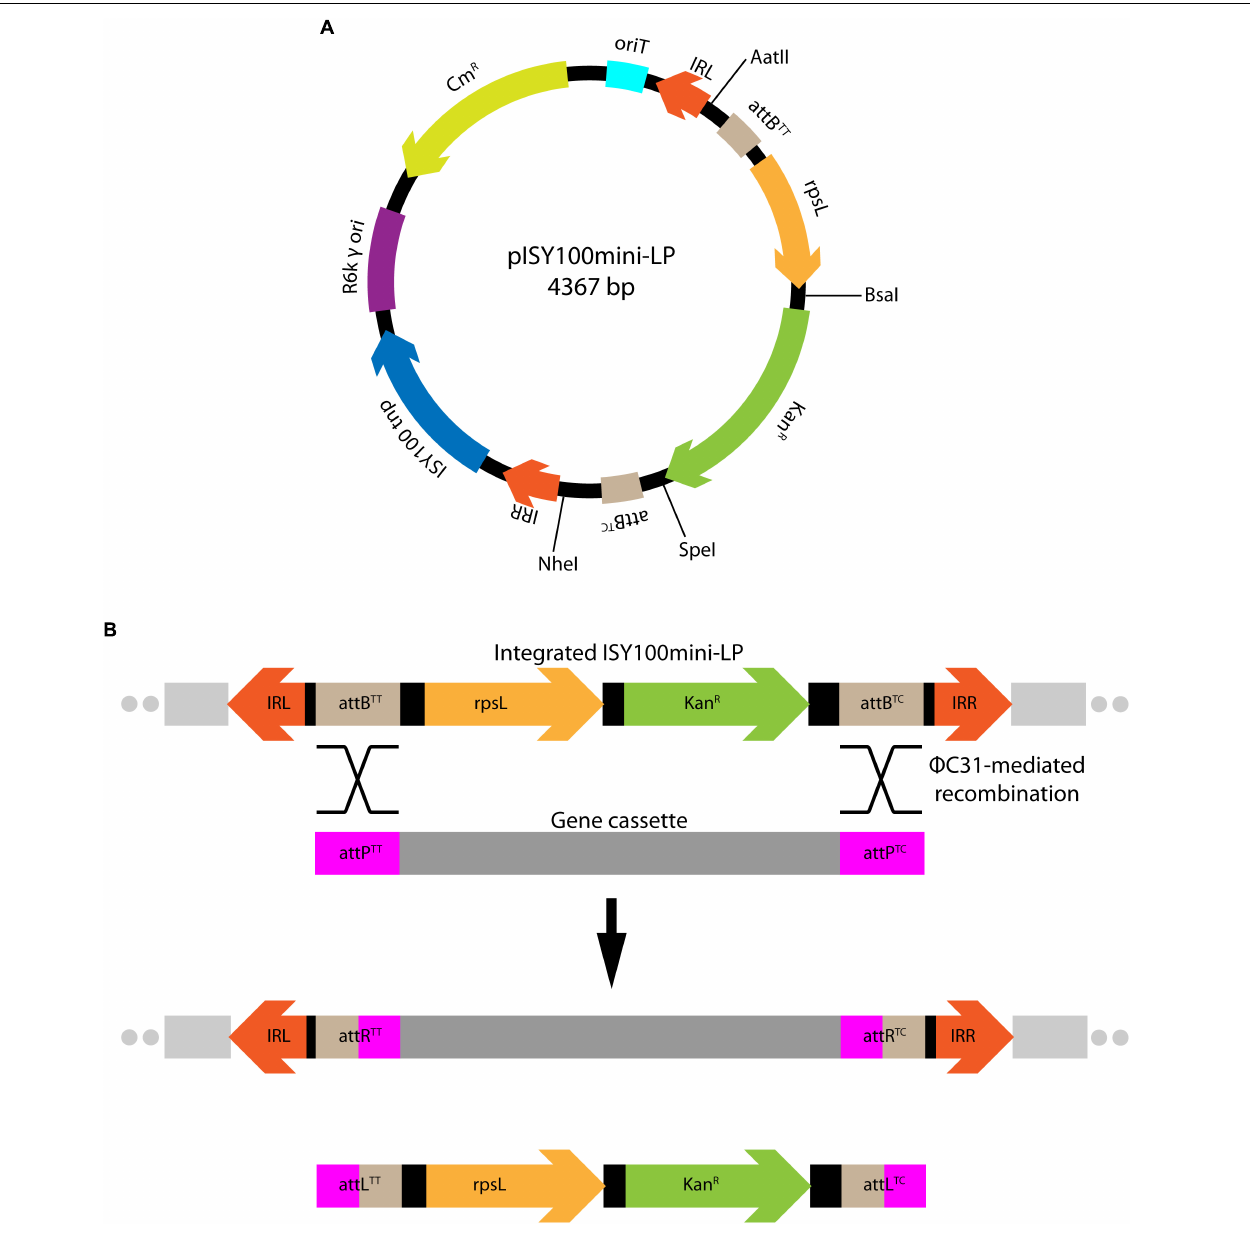
FIGURE 3 | Delivery of a chromosomal “landing pad.” (A) Map of the pISY100mini-LP vector, designed to deliver a “landing pad” for (cid:56) C31 integrase-mediated cassette exchange. The same color scheme as in Figure 1 was used for the plasmid backbone. Two (cid:56) C31 attB sites (light-brown) and the rpsL gene ( E. coli 30S ribosomal subunit protein S12 – light-orange) conferring streptomycin sensitivity to an otherwise streptomycin resistant E. coli rpsL mutant strain, were added in the mini-ISY100 transposon sequence. (B) Mini-ISY100-LP integrated on the chromosome and genetic cassette exchange attB / attP recombination. The two attB sites inserted in the landing pad can be used to integrate a gene cassette (dark gray) flanked by two attP sites (pink) via (cid:56) C31 integrase-mediated recombination.